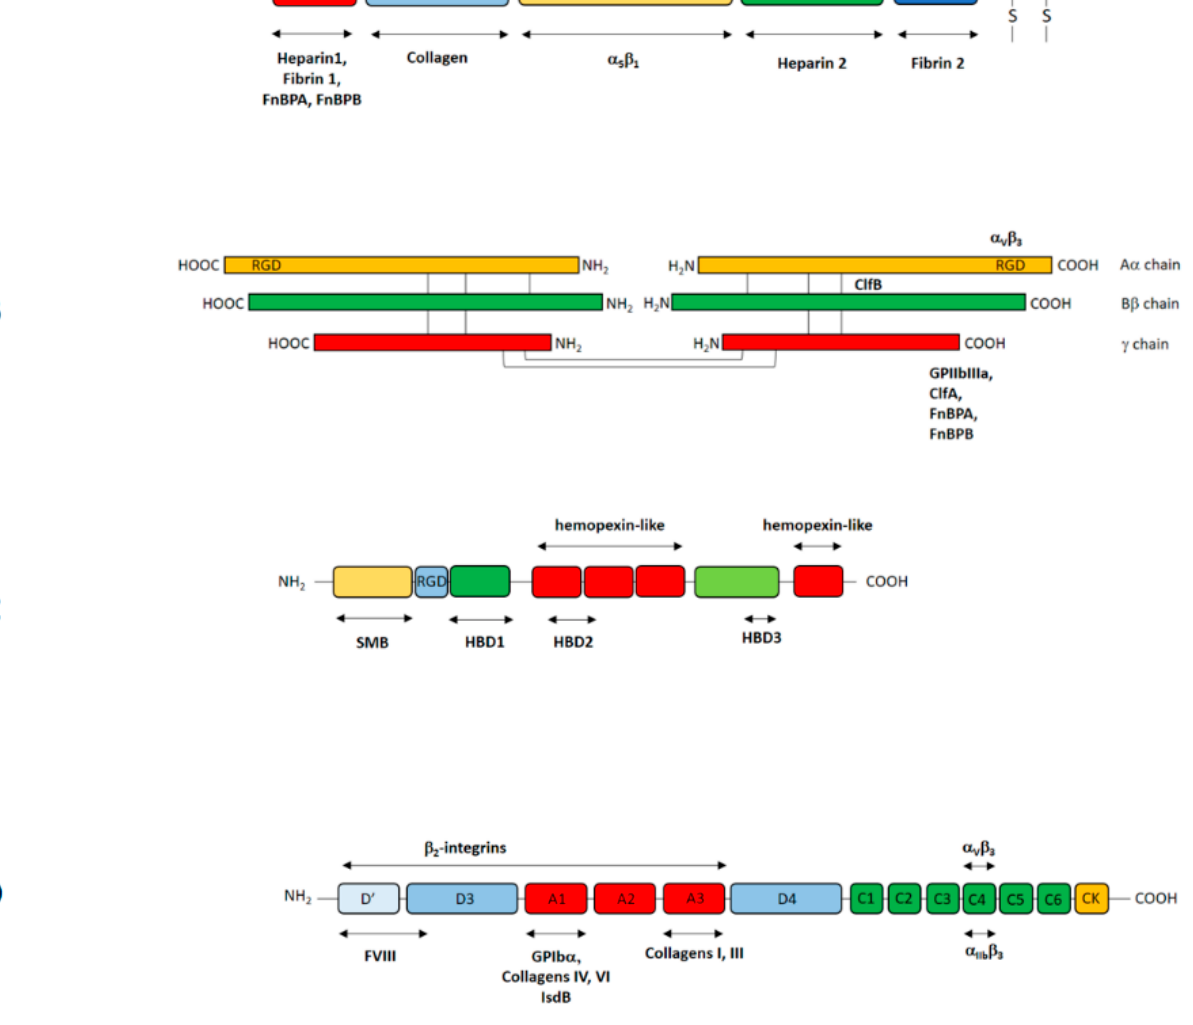
Figure 2. Schematic depiction of the extracellular matrix /plasma human proteins. ( A ) fibronectin; ( B) fibrinogen; ( C ) vitronectin; ( D ) von Willebrand factor; For each protein, domain organization is indicated. The binding sites for specific ligands on each protein are also reported.